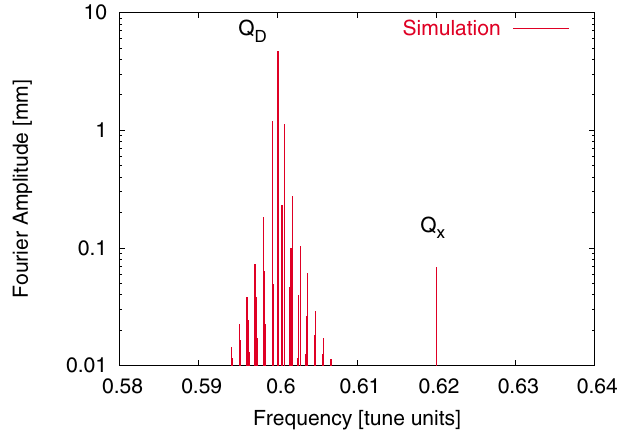
FIG. 6. (Color) Fourier spectrum of the simulated turn-by-turn particle position during the ramping process of an ac dipole. The natural and the ac dipole tunes are labeled with Q respectively.